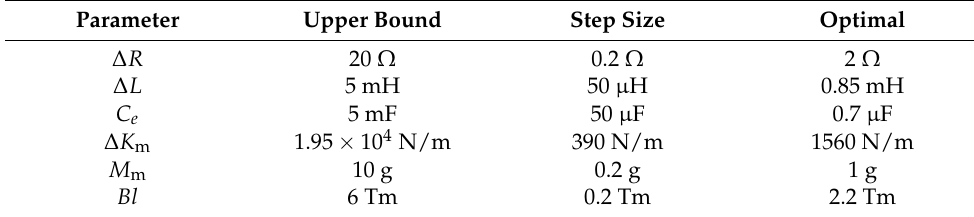
Table 2. Parameter upper bounds and step size